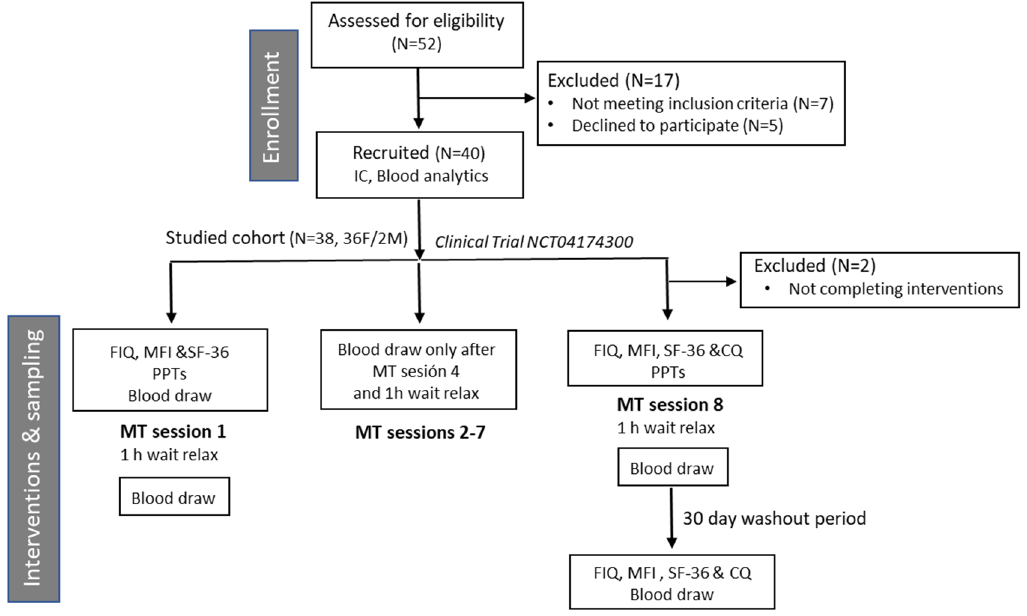
Figure 1. Flowchart depicting enrollment, intervention and sampling steps of the NCT04174300,